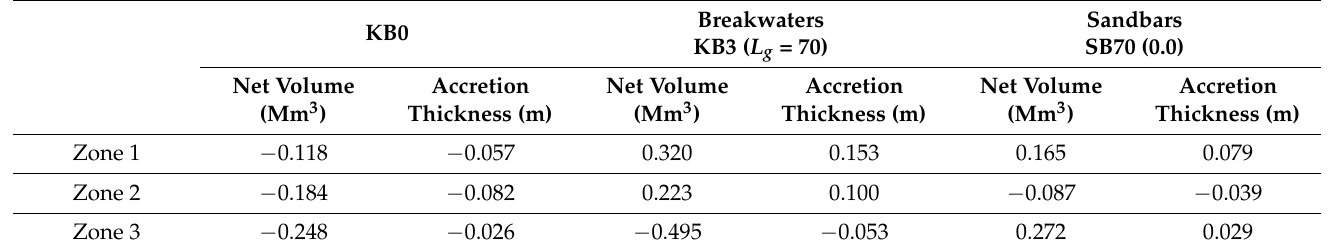
Table 8. Comparison of morphological impacts of breakwaters simulated by MIKE21 FM and TELEMAC ‐ 2D.